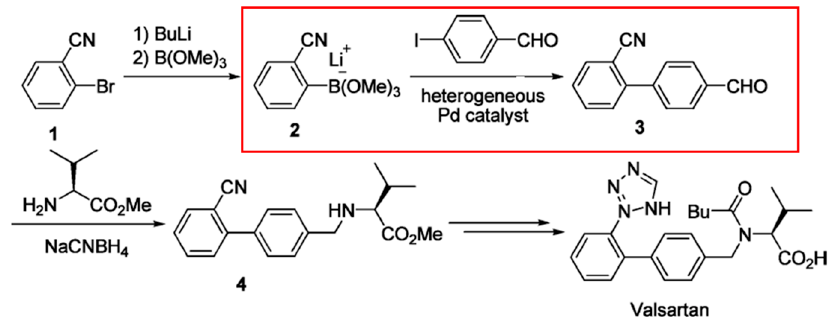
Figure 1. Synthesis of valsartan. The reaction within the red frame is coupling reaction.